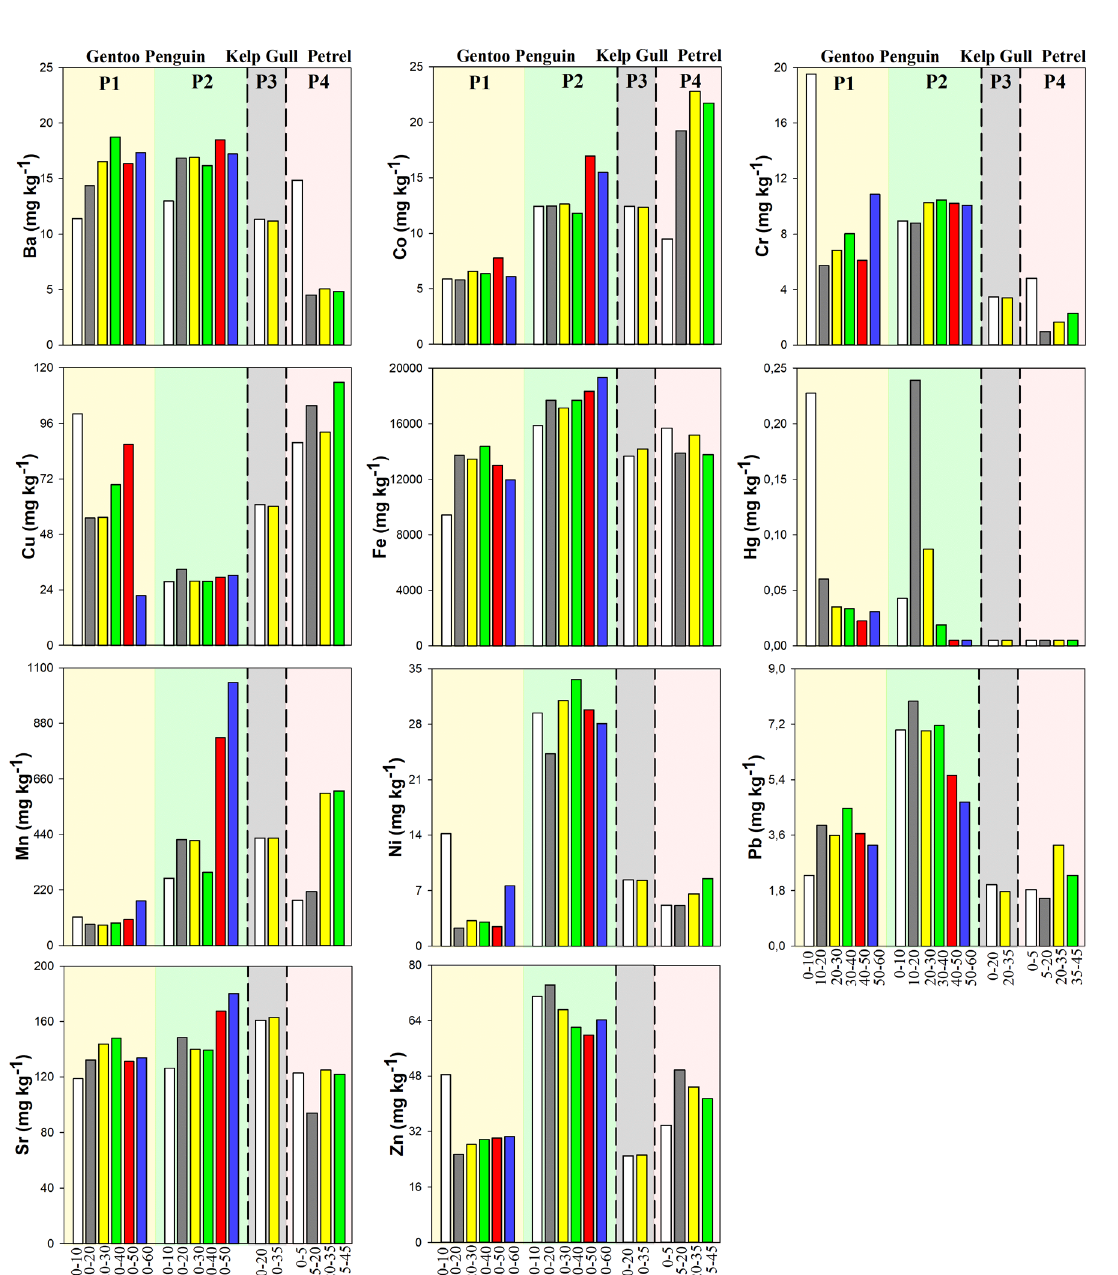
Figure 4. Contents of metals (Ba, Co, Cr, Cu, Fe, Hg, Mn, Ni, Pb, Sr and Zn) from different soil depths (cm) under the influence of gentoo penguins (P1 and P2) in the Livingston Island, and by kelp gulls (P3) and giant petrels (P4) in the Nelson Island,